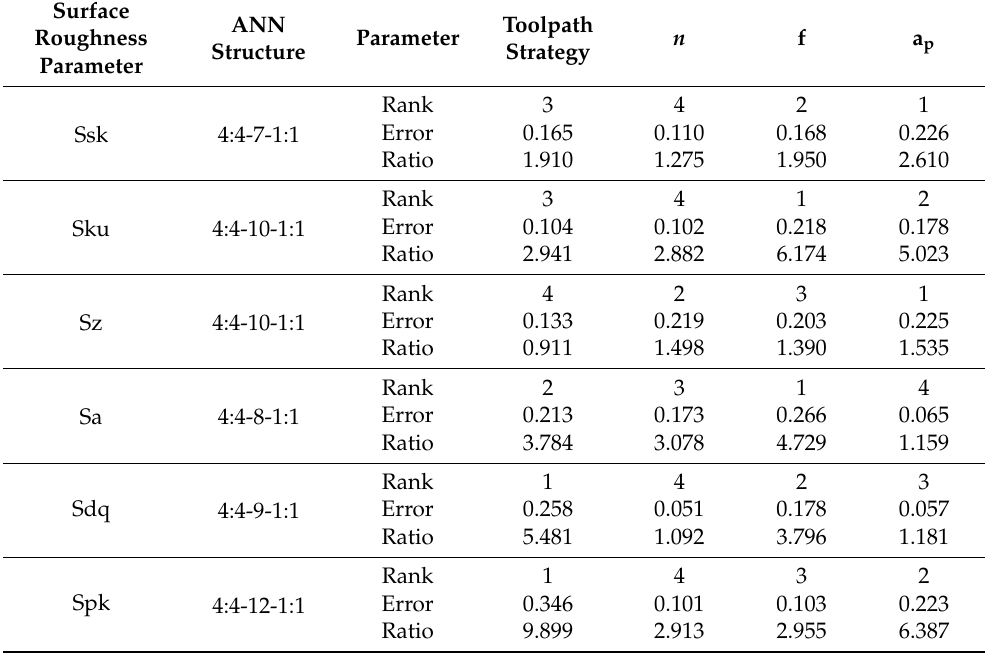
Table 7. The results of the sensitivity analysis for surface roughness parameters measured on the inner side of the drawpiece.